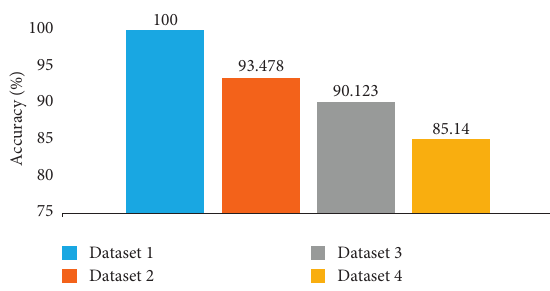
Figure 8: Total performance comparison of four